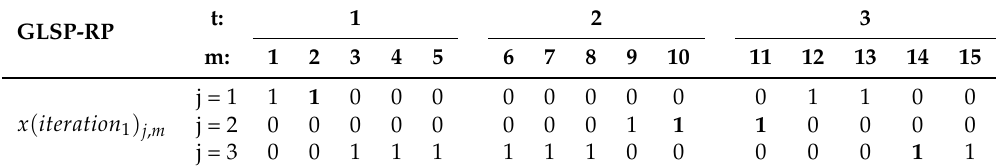
Table 7. Output production sequence of Iteration 1 for the GLSP-RP.